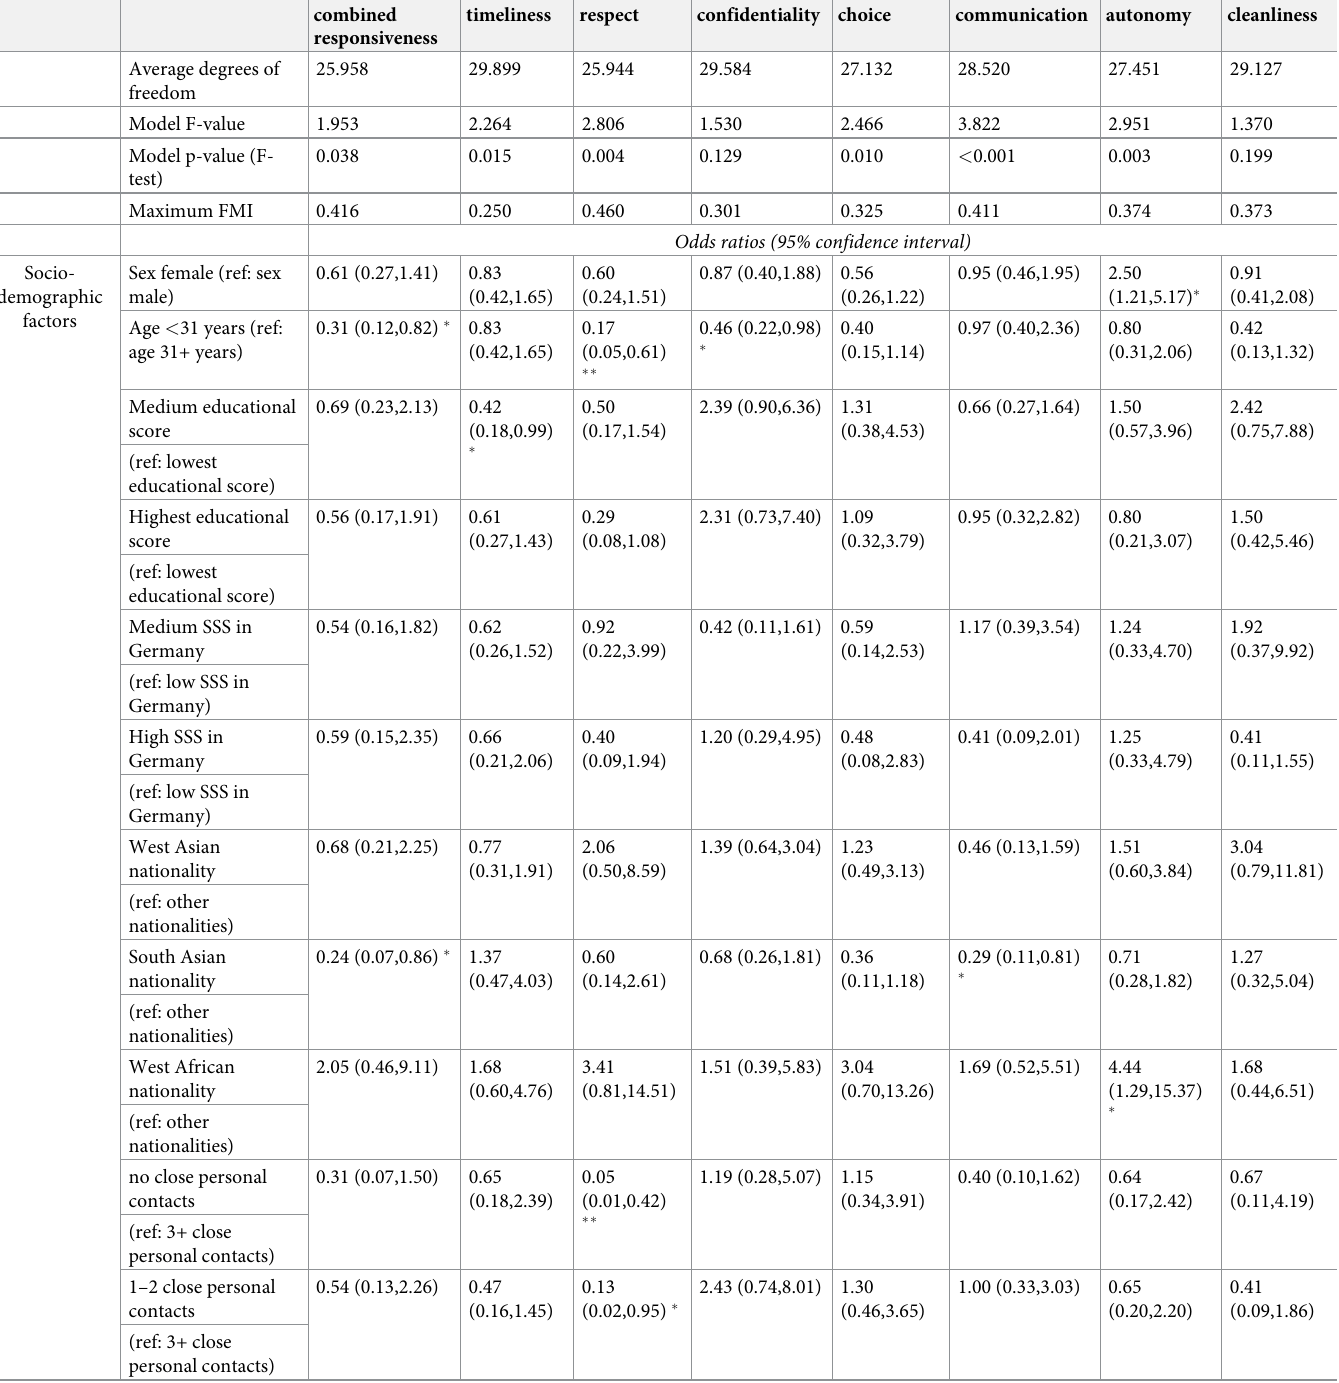
Table 4. Outcomes of multiple logistic regression models for combined responsiveness and each domain, including all potential socio-demographic, health and structural